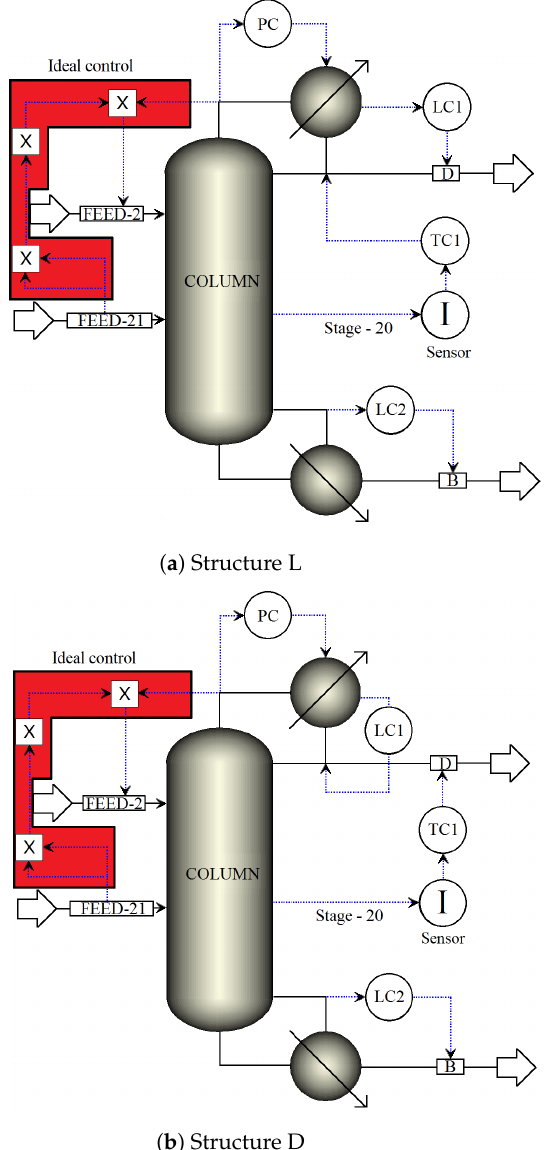
Figure 11. Structure of a single end to regulate the purity of the distillate.